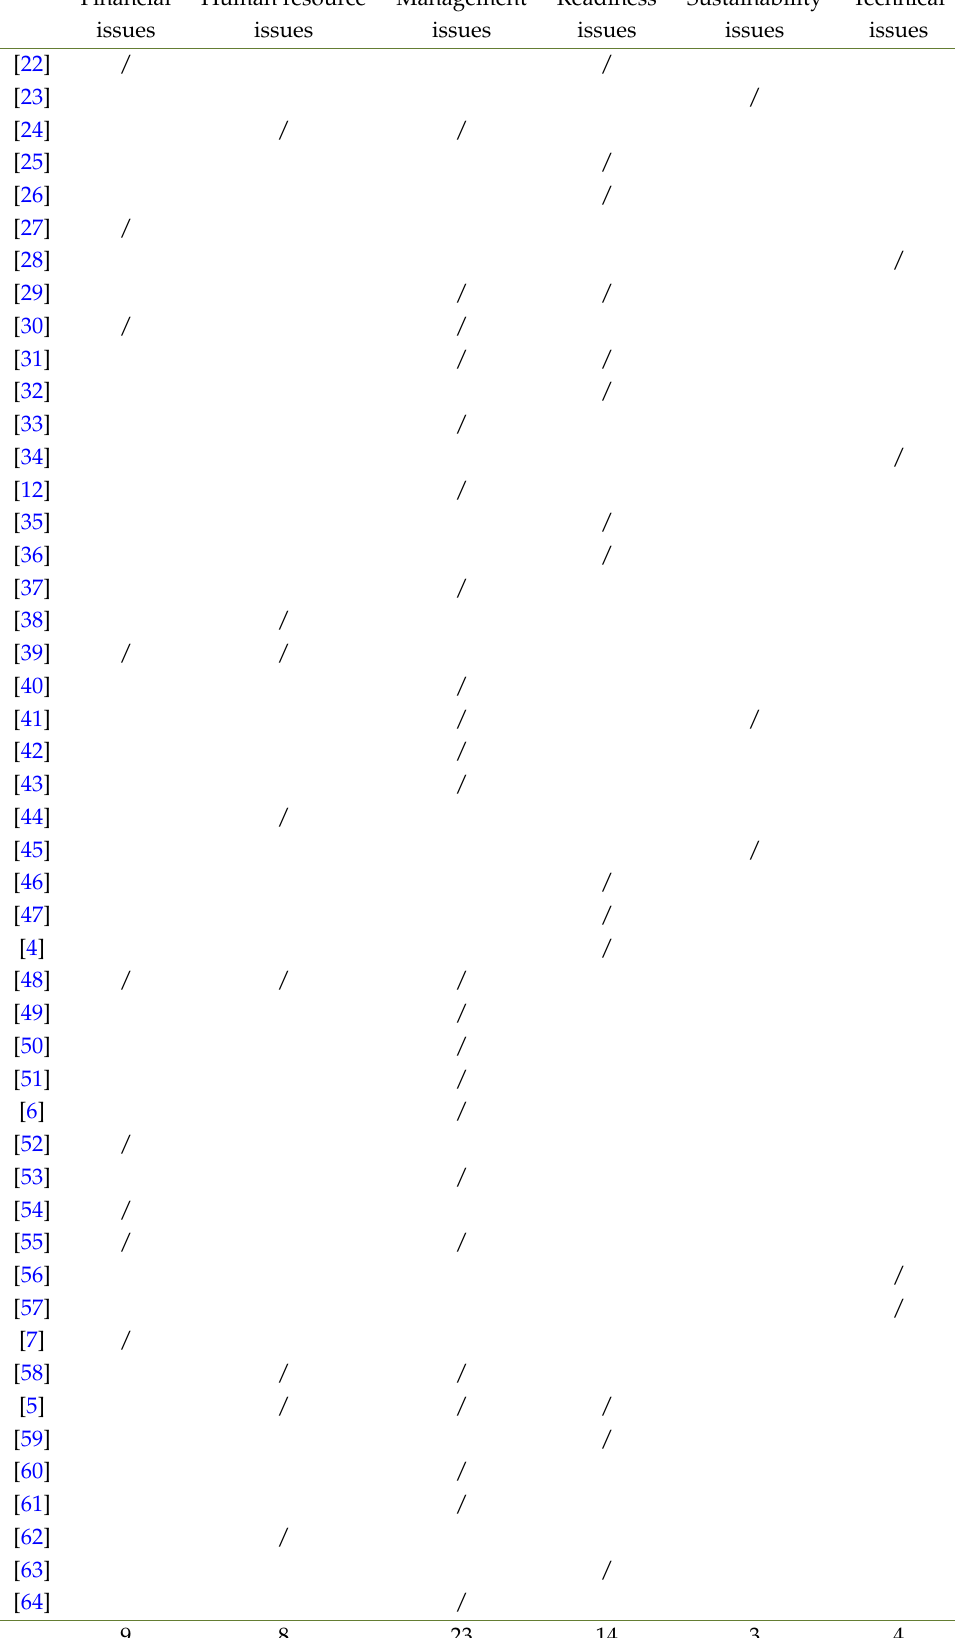
Table 3. The tabulation of authors’ discussion on IBS construction issues according to theme Financial Human resource Management Readiness Technical